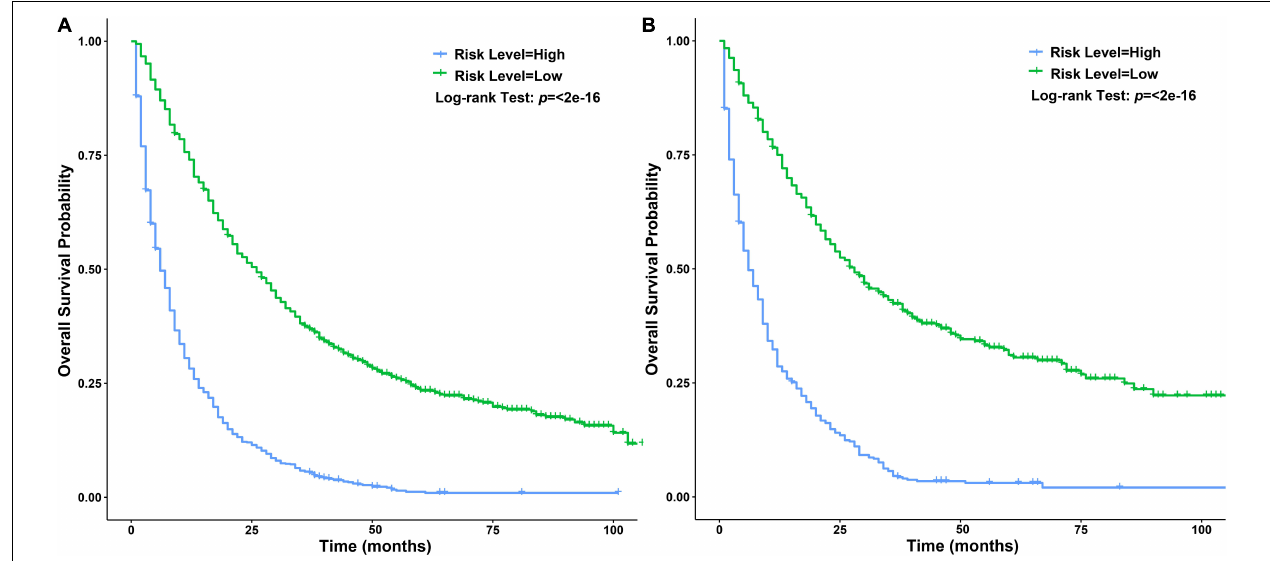
FIGURE 9 | Survival curves of patients with ICCA between different risk score level groups. (A) Survival curves of patients with ICCA between high and low risk score level groups in the training dataset. (B) Survival curves of patients with ICCA between high and low risk score level groups in the testing dataset.